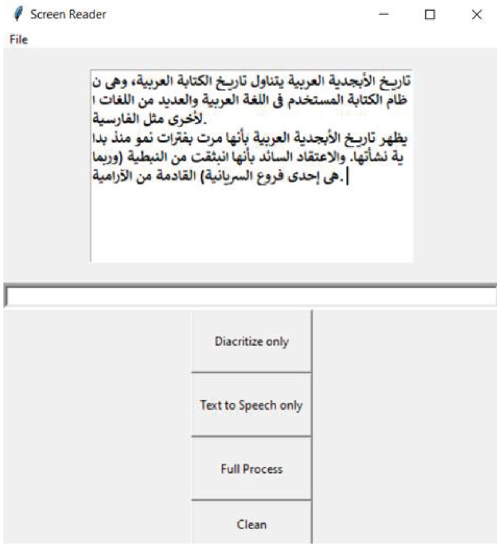
Figure 6: Example of an